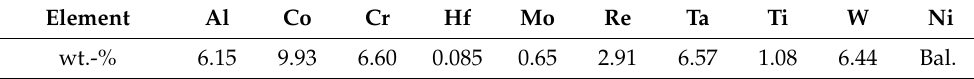
Table 1. Chemical composition of the CMSX-4 ® powder material.